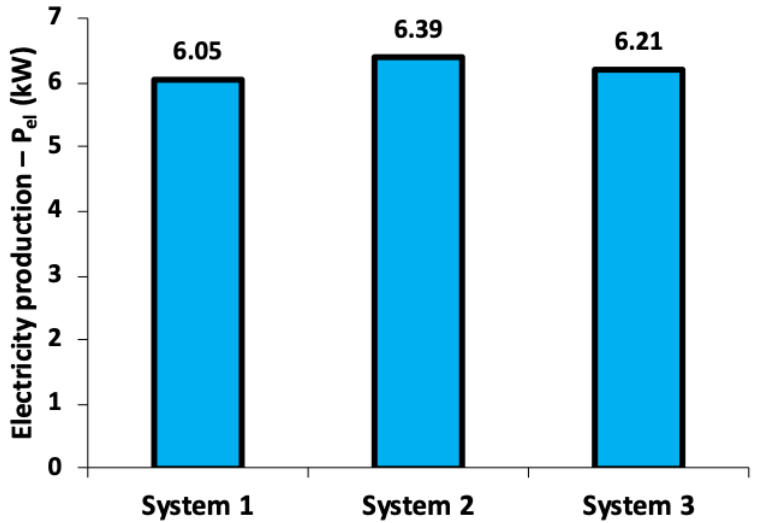
Figure 13. Electricity production of the examined systems.